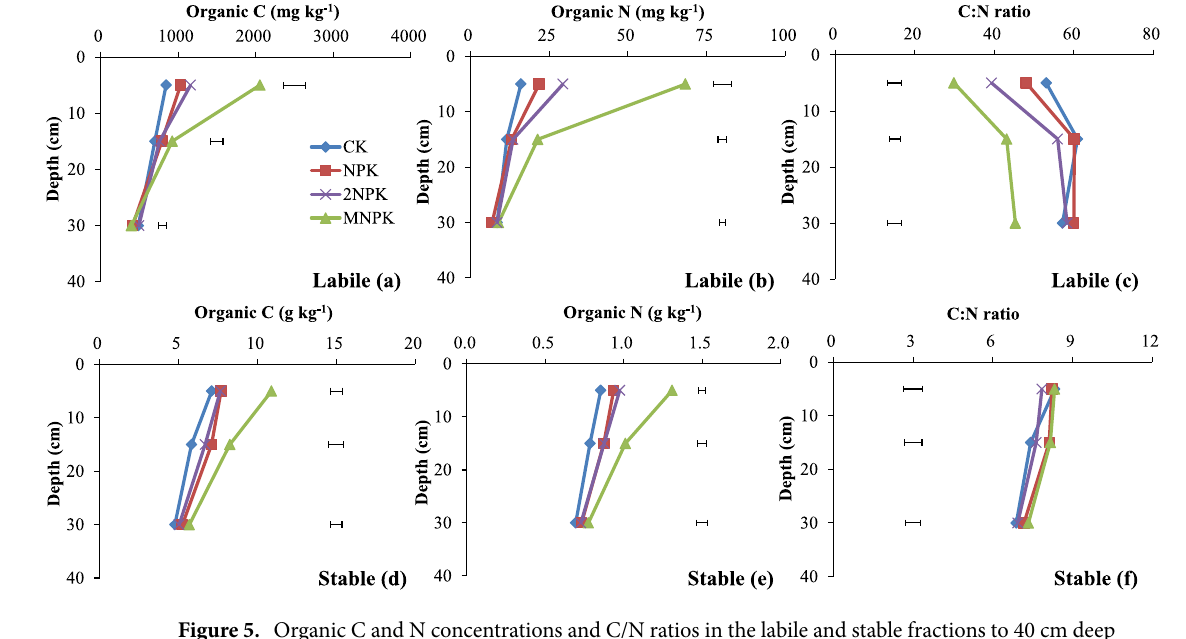
Figure 5. Organic C and N concentrations and C/N ratios in the labile and stable fractions to 40 cm deep in the control treatment (CK), chemical fertilizer treatments (NPK and 2NPK), and combined manure and chemical fertilizer treatment (MNPK). The C or N concentration of the labile fraction is the sum of the C or N concentrations of cPOM and fPOM. The C or N concentration of the stable fraction is the sum of the C or N concentration of fiPOM, free-m, free-SC, inter-SC, and intra-SC. Each value is the mean of three replicates. The horizontal lines indicate the least significant difference values at the 0.05 level (LSD0.05) for the different treatments at the different depths. The abbreviations for aggregates of each size are shown in the footnote to Table 1.